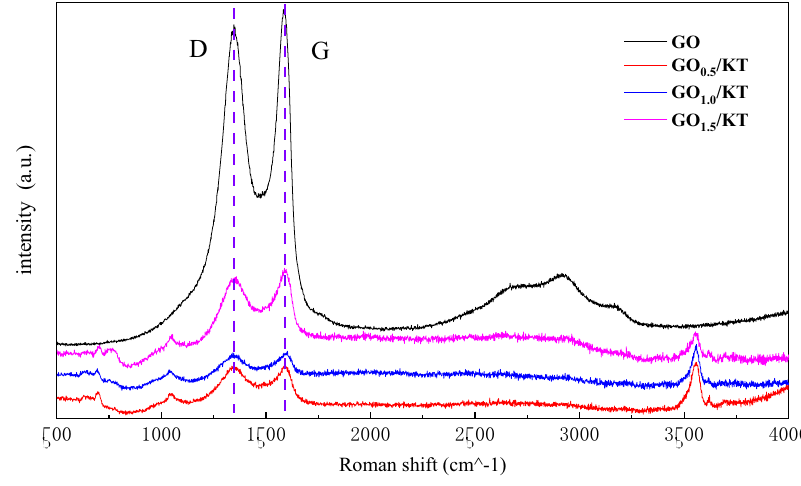
Figure 11: Raman spectra of GO/KT composites with di ff erent GO